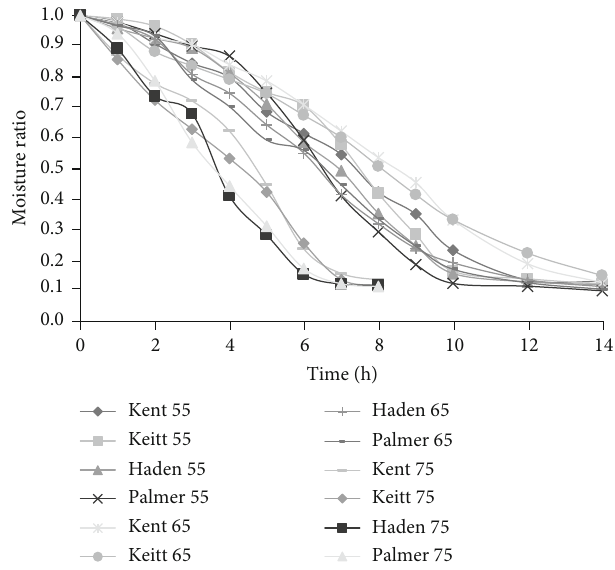
Figure 4: Moisture ratio curves at 55 ° C, 65 ° C, and 75 °